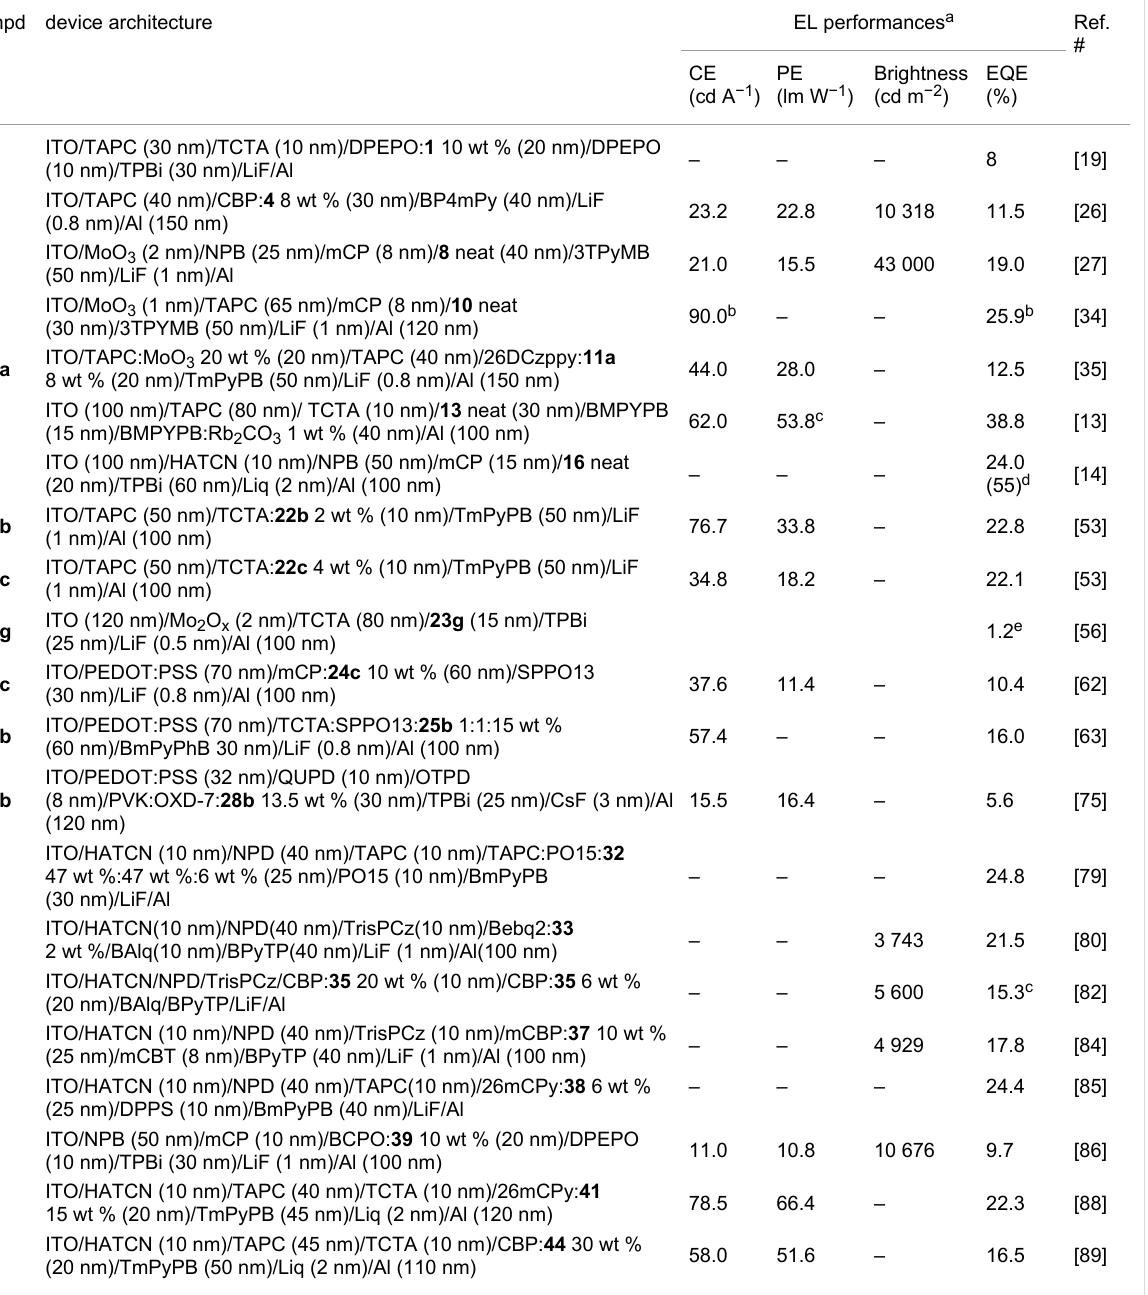
Table 1: EL device performances reported for selected examples of luminescent platinum(II) and platinum(IV) complexes reviewed in this manuscript. cmpd device